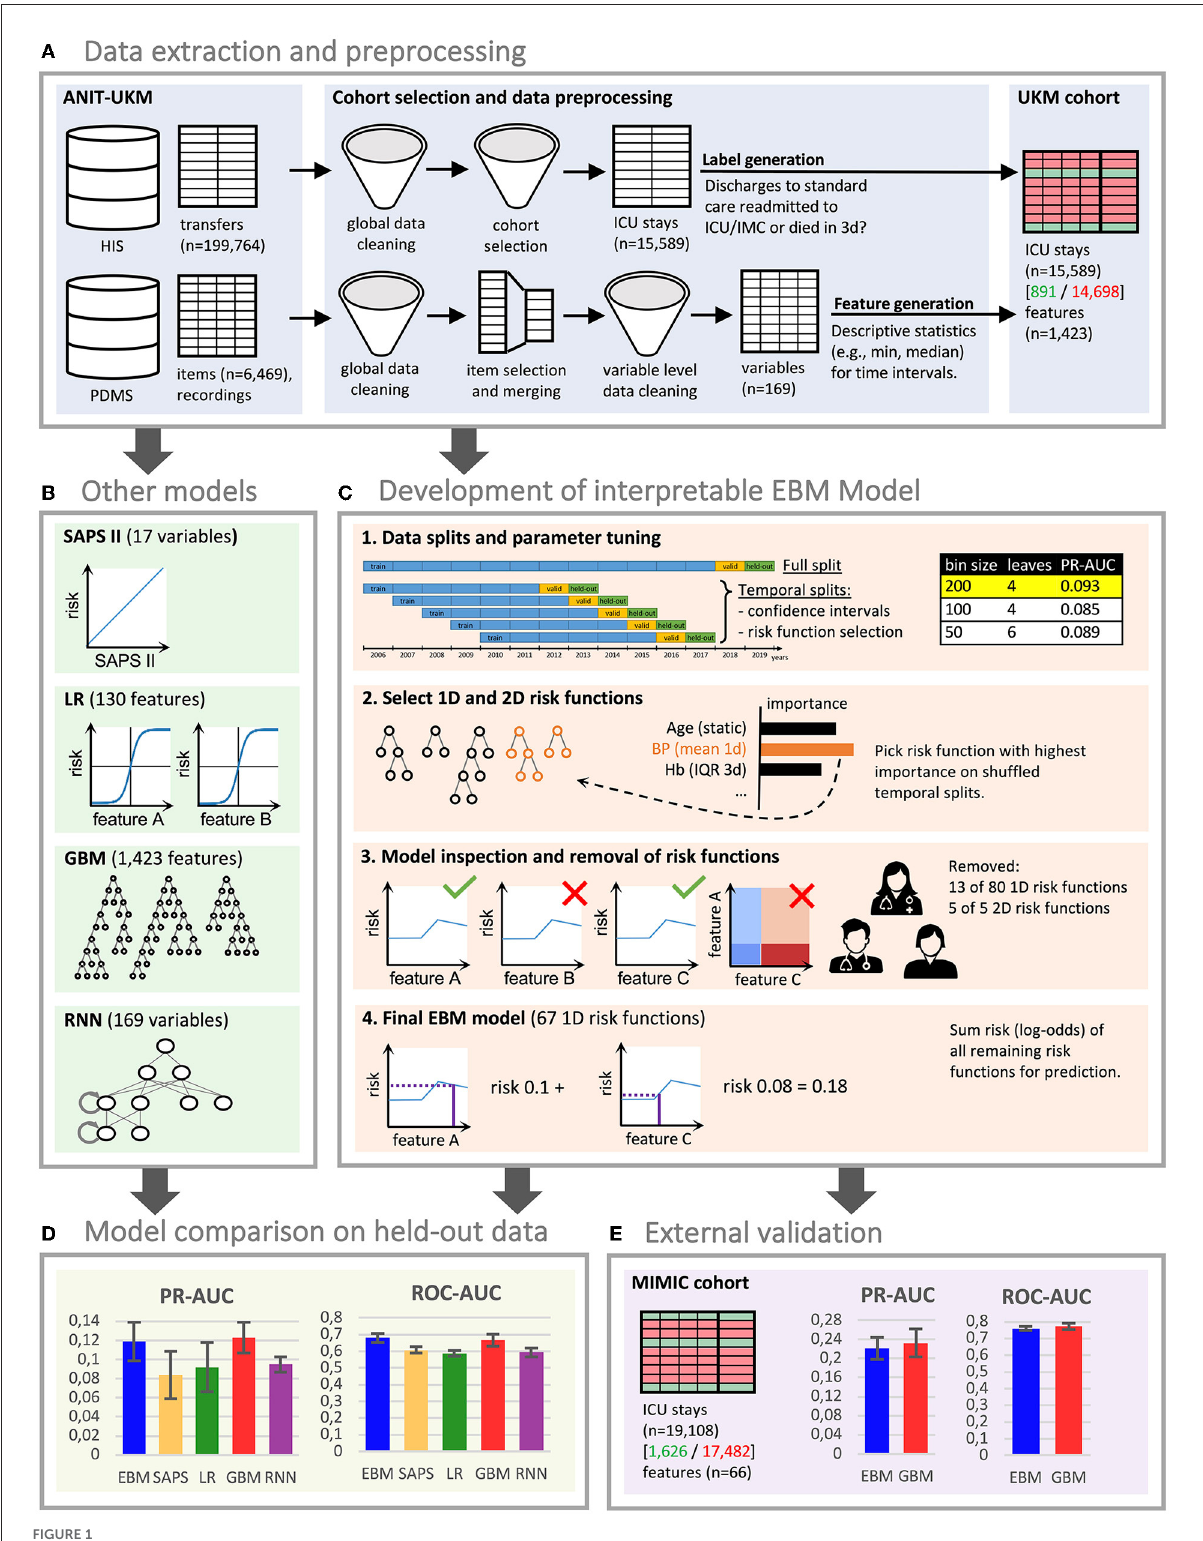
FIGURE1 Flowchart of the study. (A) We created a local cohort for the development of machine learning (ML) models. Information on intensive care unit (ICU) transfers was extracted from the hospital information system (HIS), and ICU data was extracted from the patient data management system (PDMS). Extensive preprocessing was applied to clean the data. We generated labels for 3 day ICU readmission and descriptive statistics as